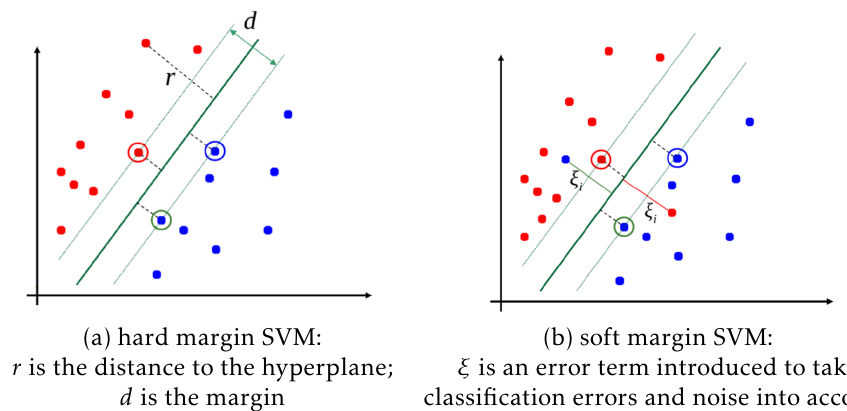
Figure 3. SVMs’ principle: The two classes (red and blue points) are separated by the SVM hyperplane (black line). Support vectors (rounded points) are the closest samples to the